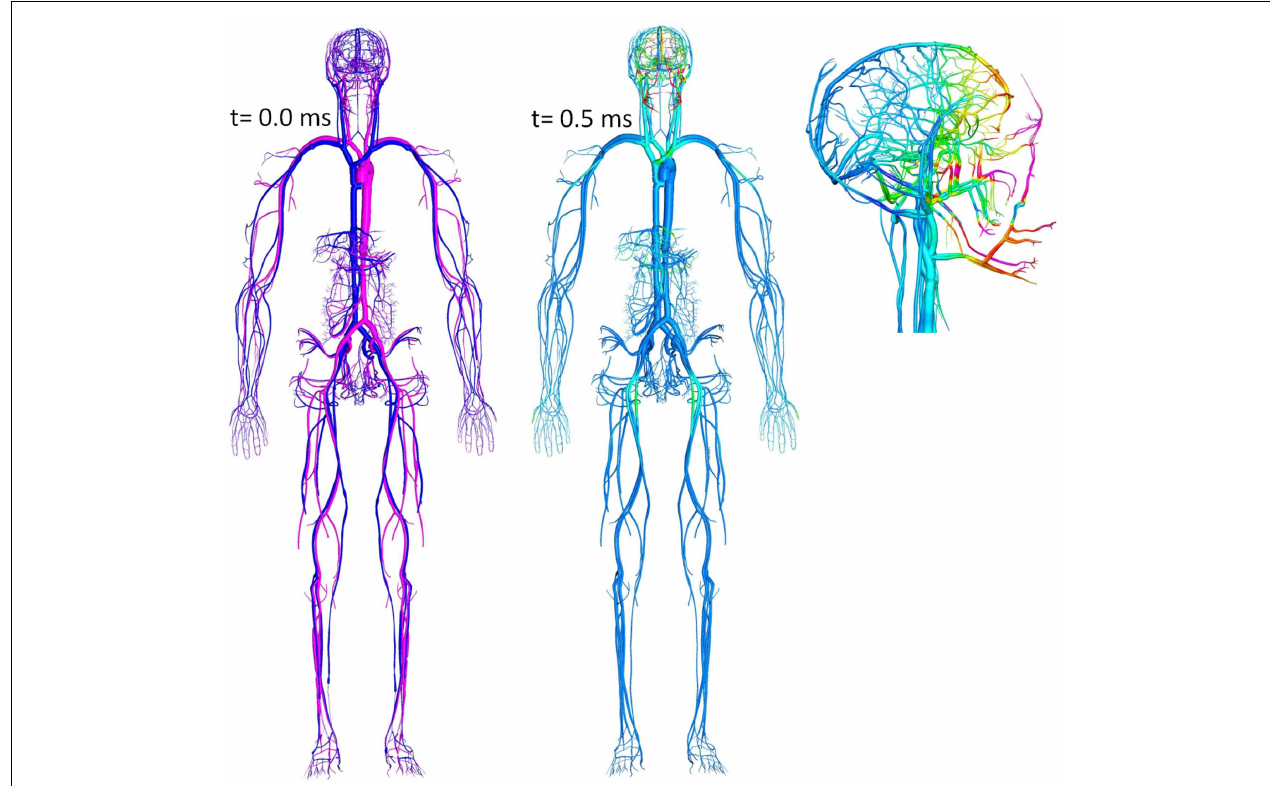
FIGURE 8 |Whole body cardiovascular system model “embedded” in the tissue biomechanics model used to study blast-induced elastic waves